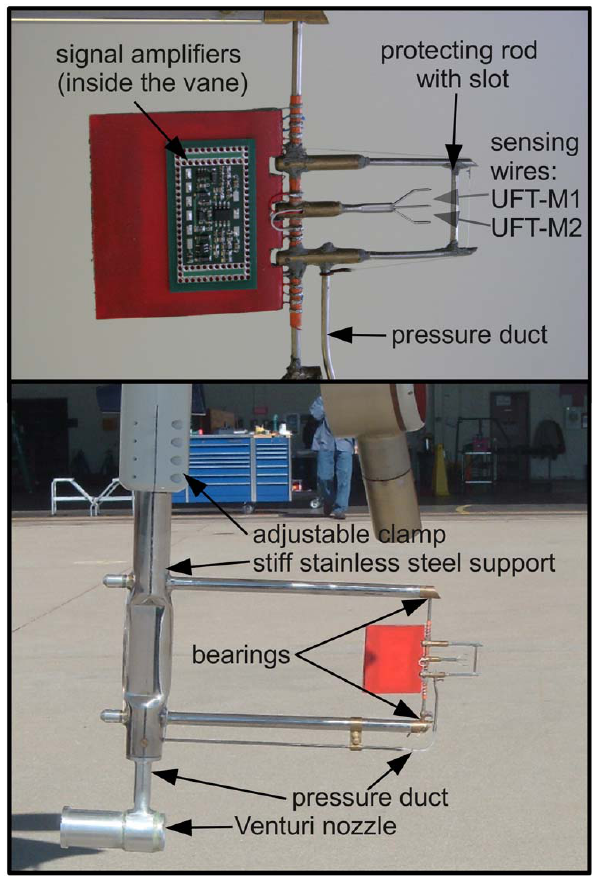
Fig. 2. The UFT-M as used in POST. Upper panel: the sensor, sens- ing wires 1 and 2 are referred as UFT-M1 and UFT-M2. A printed circuit with the electronics, here exposed, is screened and hidden inside the red tail of the vane. Lower panel: the sensor support and mounting